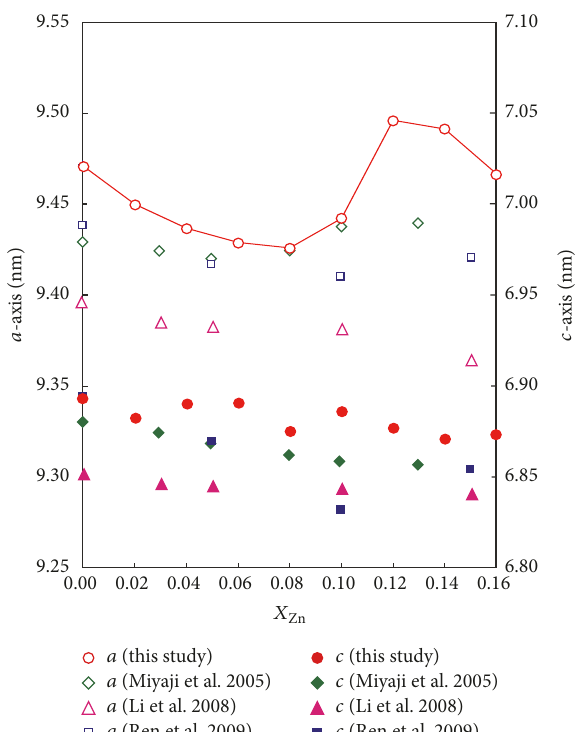
Figure 2: Change of the cell parameters 𝑎 and 𝑐 with the increasing 𝑋 Zn for the Zn-substituted hydroxylapatites [(Zn